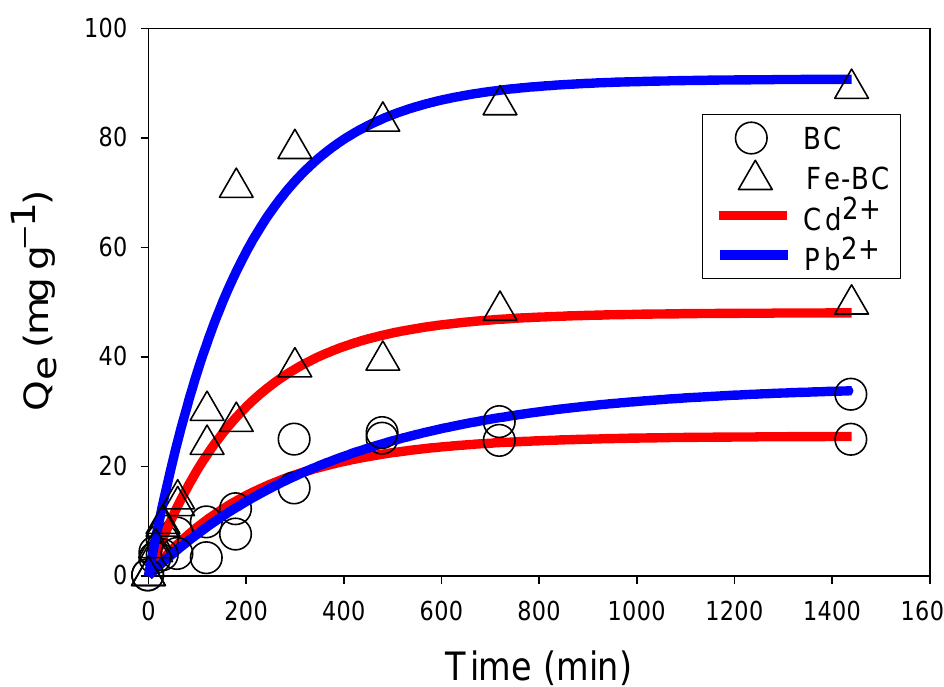
Figure 3. Effect of contact time on the adsorption of cadmium (Cd 2+ ) and lead (Pb 2+ ) on date palm waste biochar (BC) and Fe-modified biochar (Fe-BC). Table 3. Parameters obtained from kinetic models for cadmium (Cd 2+ ) and lead (Pb 2+ ) adsorption on date palm waste biochar (BC) and Fe-modified biochar